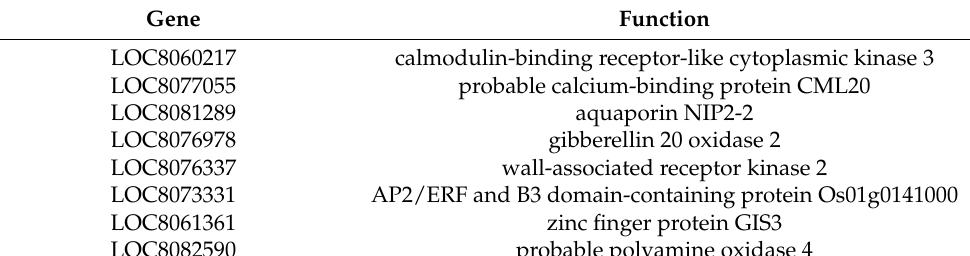
Table 2. List of genes commonly down-regulated in both leaves and roots grown under salt stress. Gene